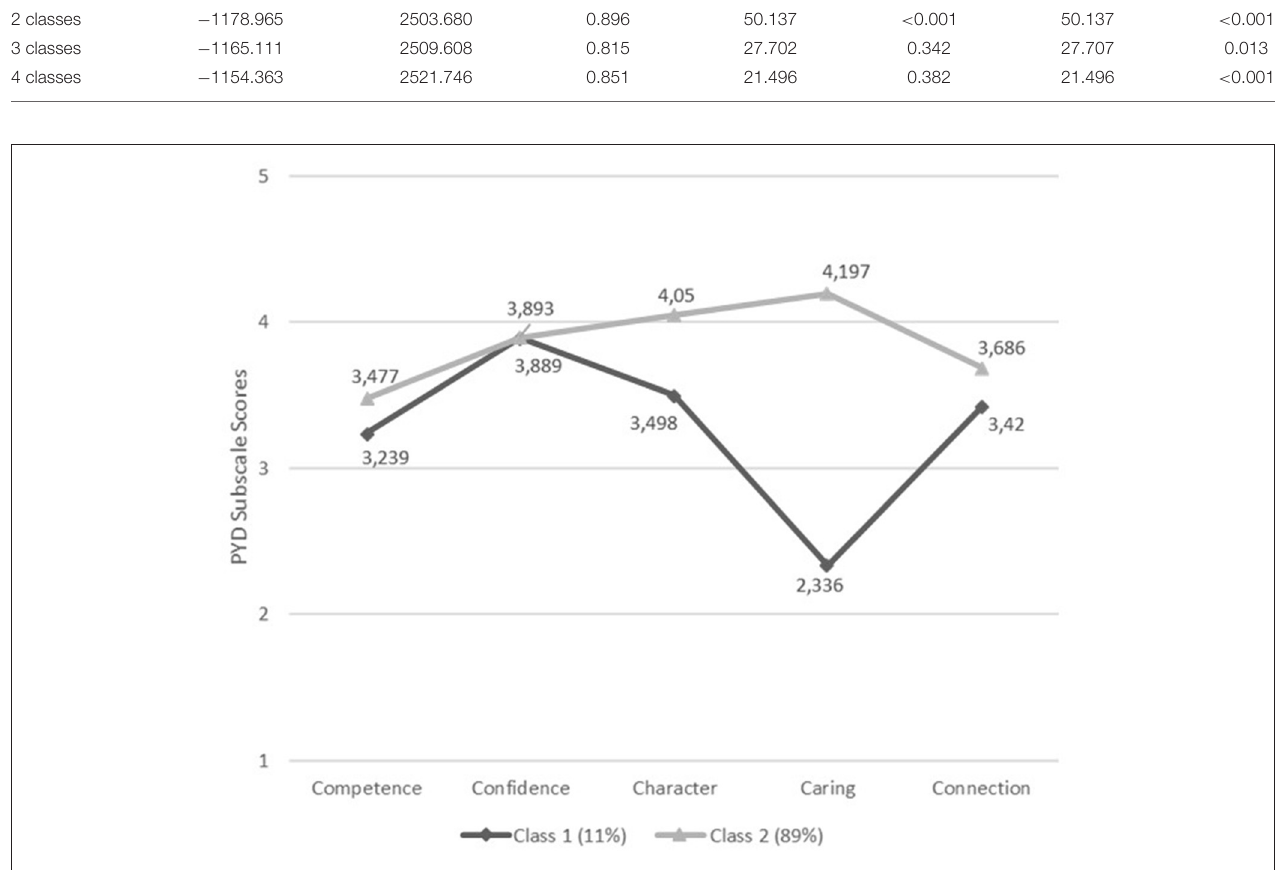
FIGURE 1 | A profile plot for the 2-class model.